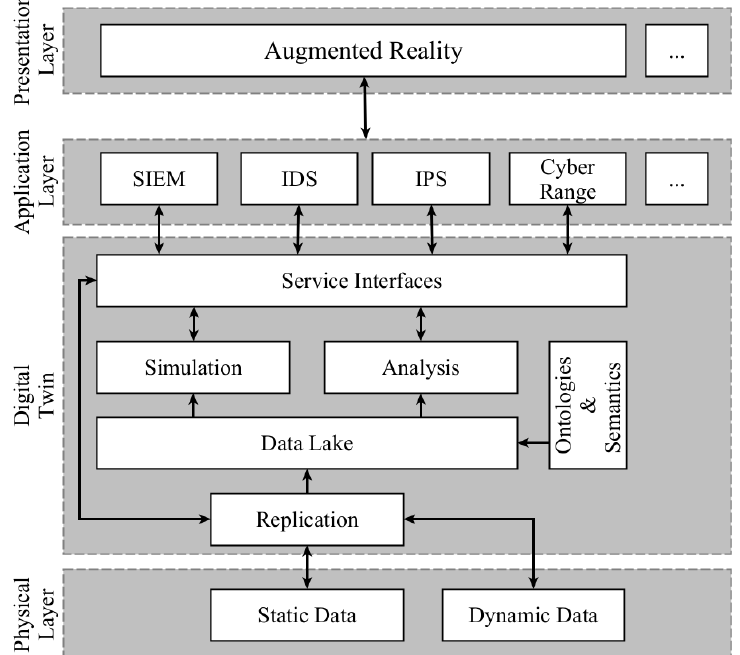
Figure 6. Conceptual architecture for AR-DT combination in